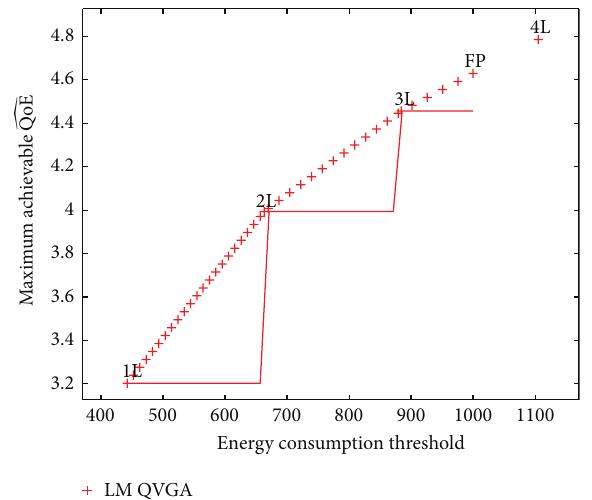
Figure 3: Comparison between basic strategy and QoE optimiza-